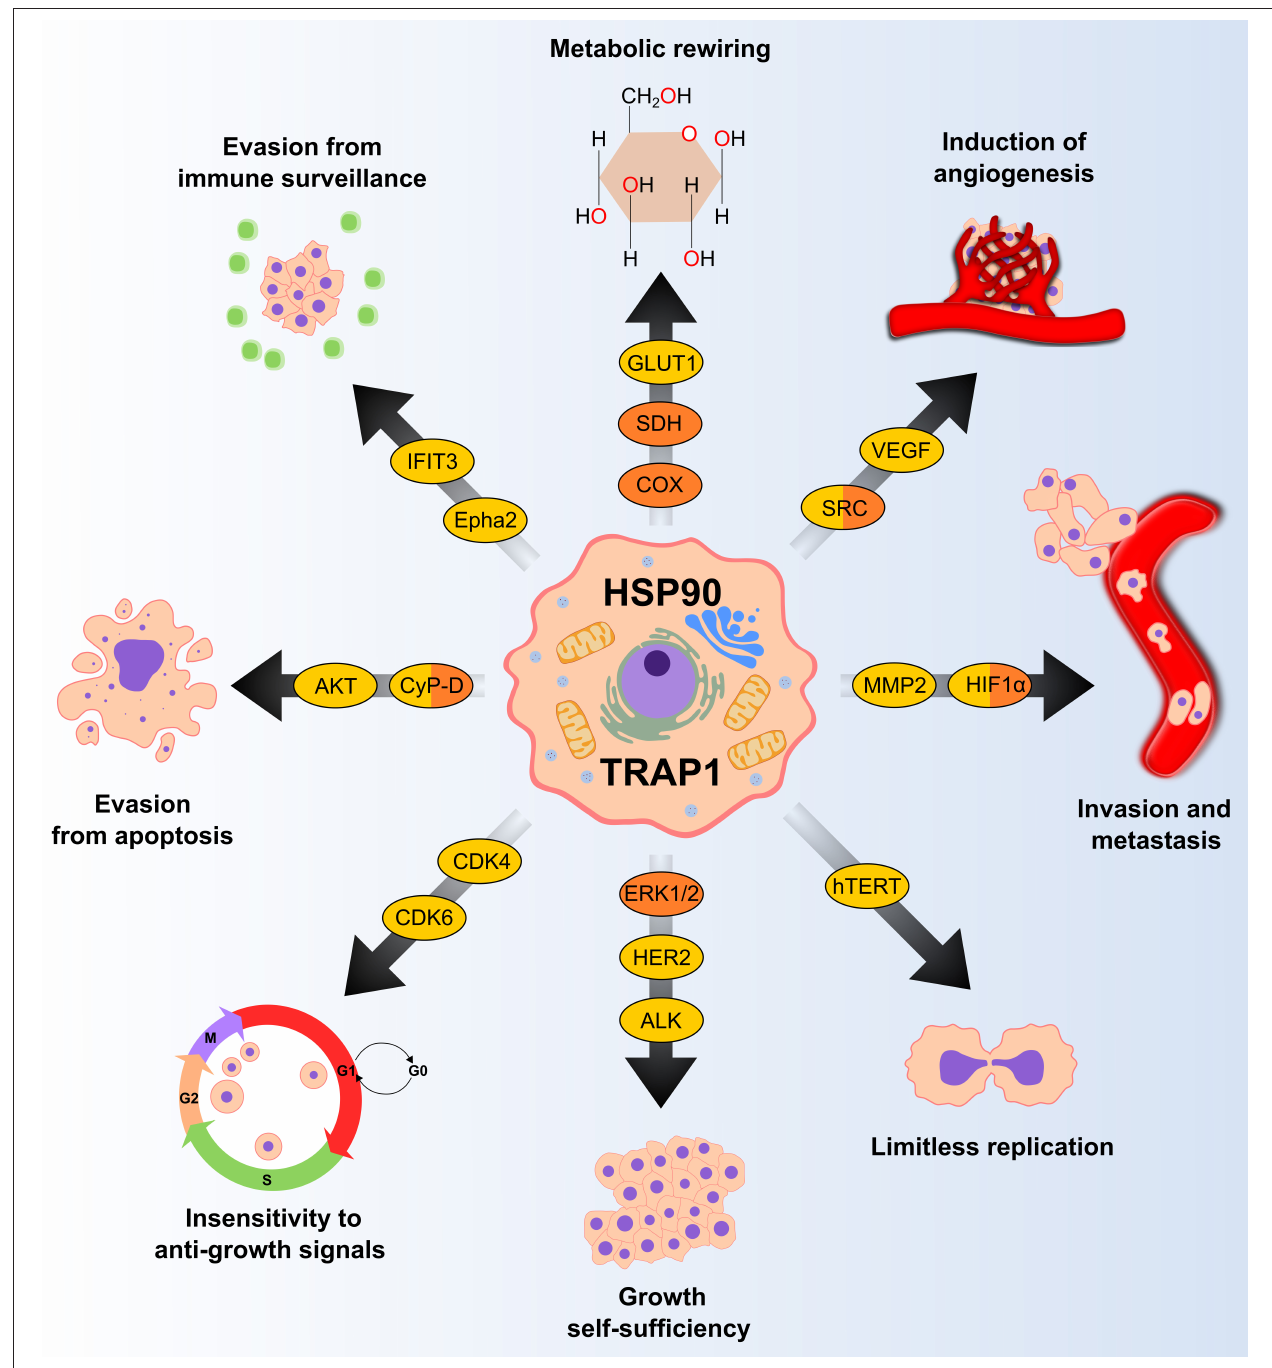
FIGURE 1 | HSP90 and TRAP1 chaperones are involved in several pro-neoplastic biological processes. Many clients of HSP90 and TRAP1 (in yellow and orange, respectively) are proteins that regulate key tumorigenic processes. GLUT1, glucose transporter 1; SDH, succinate dehydrogenase; COX, cytochrome c oxidase; VEGF, vascular endothelial growth factor; MMP2, matrix metallopeptidase 2; HIF1 α , hypoxia-inducible factor 1-alpha; hTERT, human telomerase reverse transcriptase; ERK 1/2, extracellular signal-regulated kinase 1/2; HER2, human epidermal growth factor receptor 2; ALK, anaplastic lymphoma kinase; CDK, cyclin-dependent kinase; CyP-D, cyclophilin D; Epha2, ephrin type-A receptor 2; IFIT3; Interferon induced protein with tetratricopeptide repeats 3.